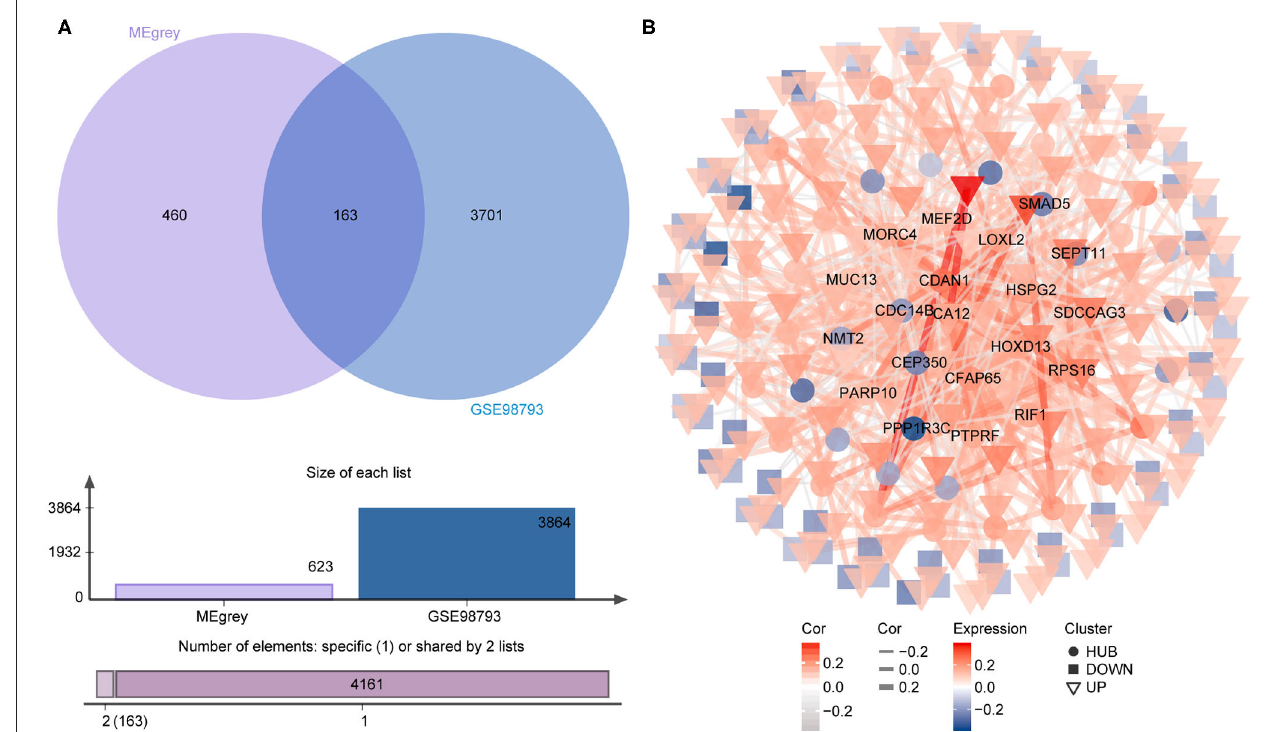
FIGURE 2 | The differential expressed gene intersection between MEgrey and GSE98793. (A) The calculation progression of intersection between MEgrey and GSE98793; (B) The reconstruction of the co-expression differential expressed gene network from MEgrey module.